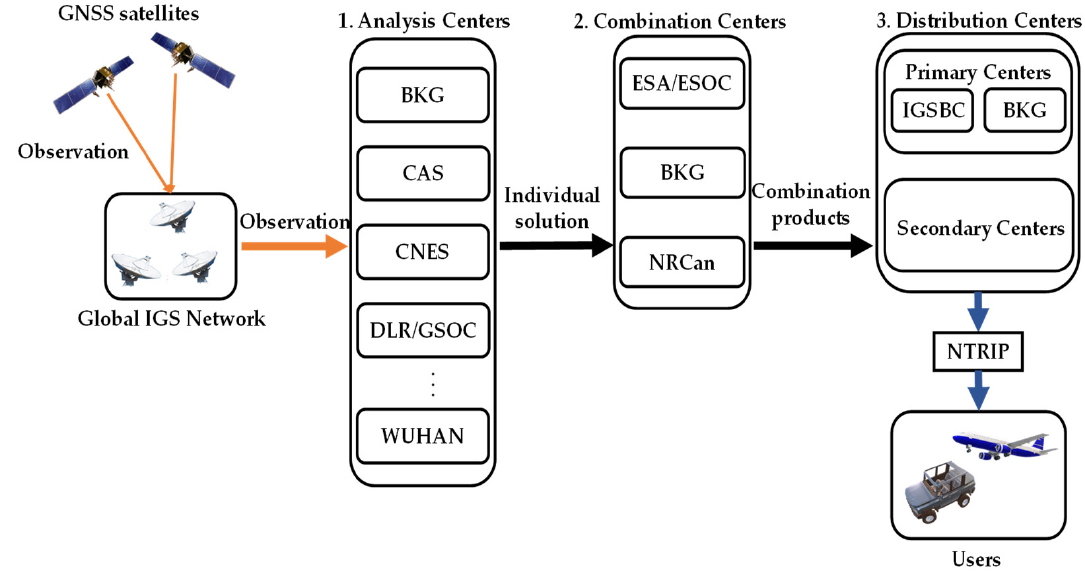
Figure 1. Flowchart for generating RTS orbit and clock corrections.